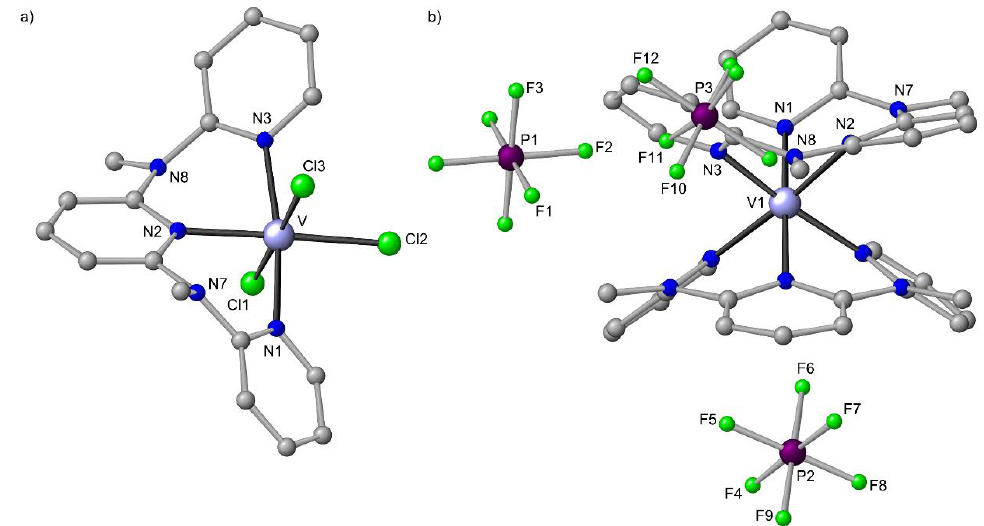
Figure 11. Molecular structures of ( a ) mer -VCl 3 (ddpd) and ( b ) cis - fac -[V(ddpd) 2 ][PF 6 ] 3 in the solid state; hydrogen atoms and solvent molecules omitted. Atom numbering unified for clarity.